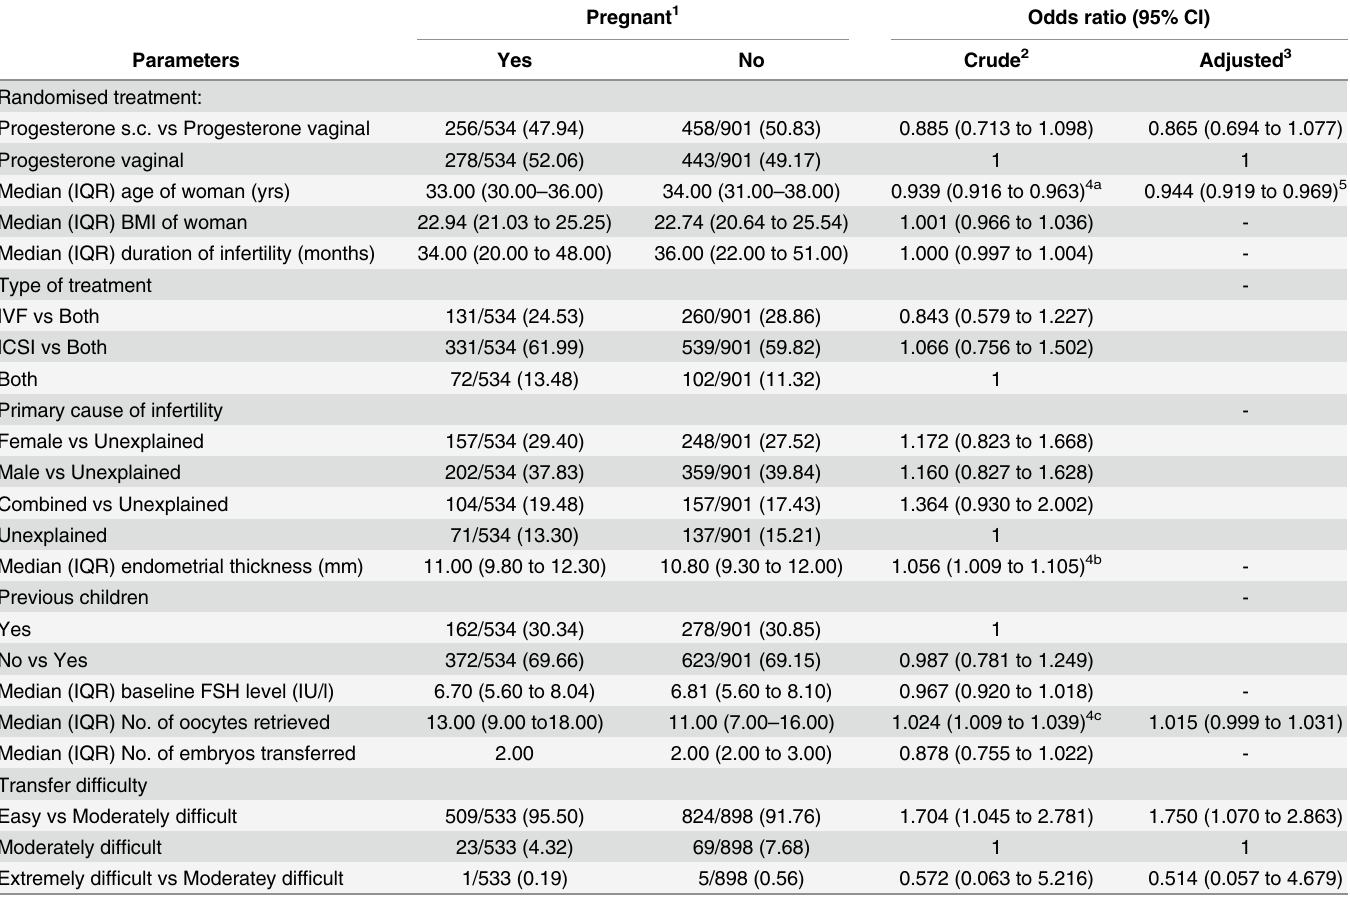
Table 2. Predictors of ongoing pregnancy after progesterone treatment. Figures are numbers (percentages) unless stated otherwise. Pregnant 1 Odds ratio (95%